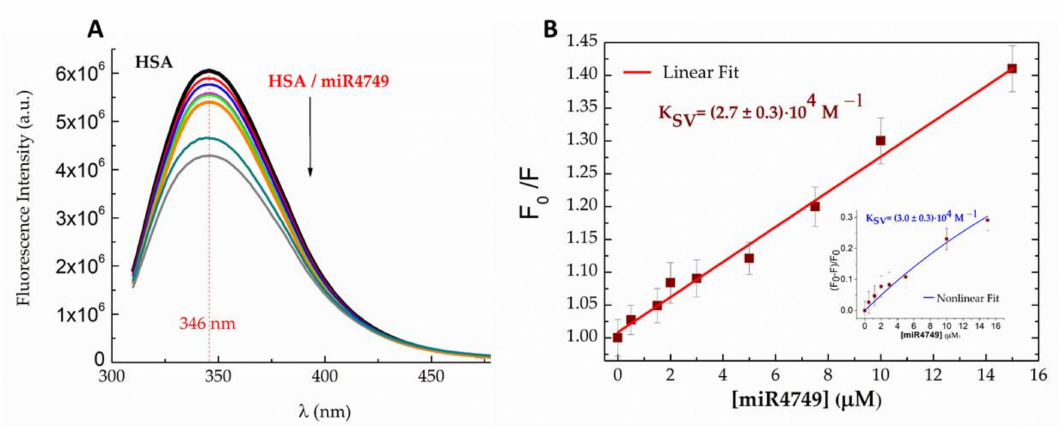
Figure 1. ( A ) Fluorescence emission spectra of 5 µ M HSA in PBS buffer (pH 7.4), alone (black line) and with increasing concentrations of miR4749 (0.5–15 µ M, coloured lines) at 298K; λ exc = 295 nm. ( B ) Lin- ear Stern–Volmer plot of the fluorescence quenching of HSA as a function of miR4749 concentration (dark red squares), fitted by Equation (3) (red line); the extracted K SV value being reported. Inset: Non- linear Stern–Volmer plot of the fluorescence quenching of HSA as a function of miR4749 concentration (dark red squares), fitted by Equation (4) (blue line); the extracted K SV value being reported.